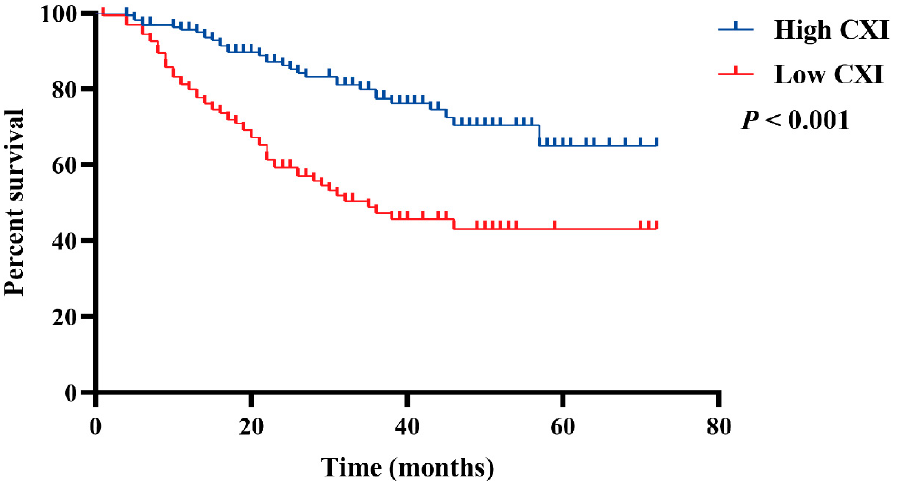
Figure 2. Comparison of OS between patients with low cachexia index and high cachexia index.